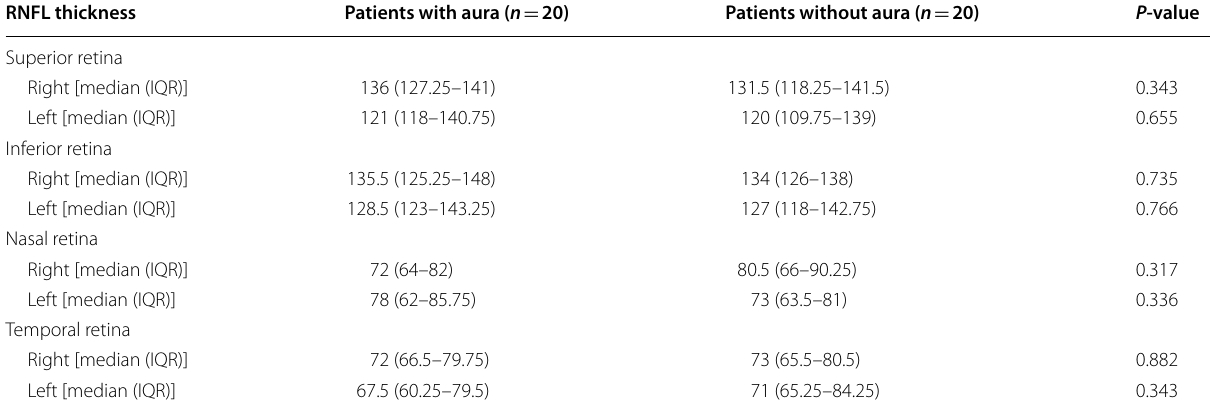
n number, RNFL retinal nerve fiber